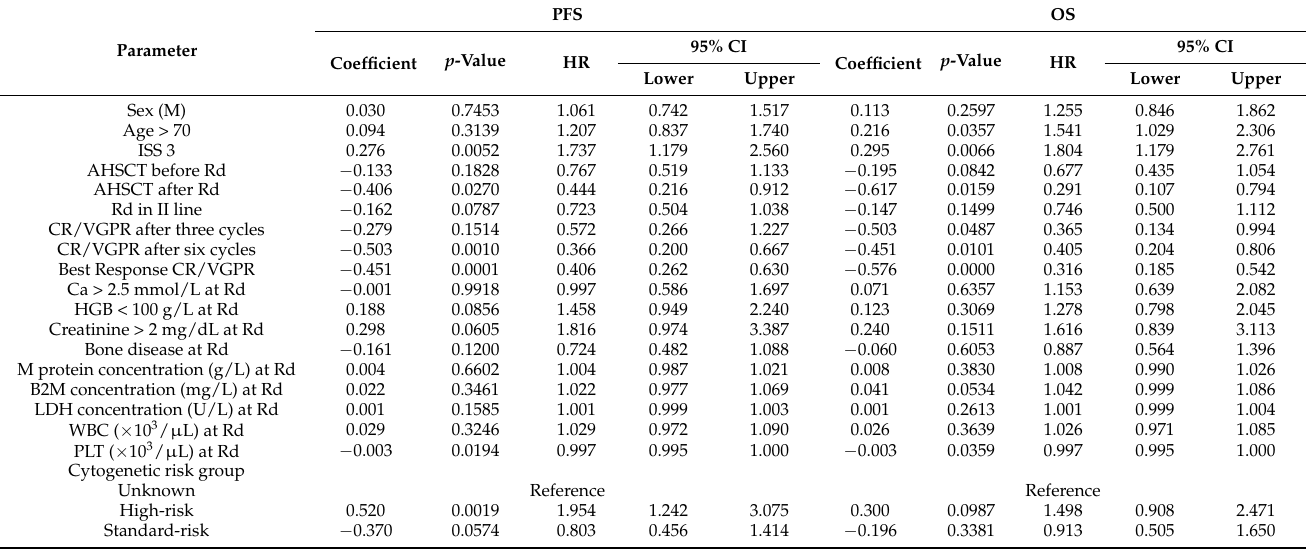
Table 2. Univariate Cox regression for PFS and